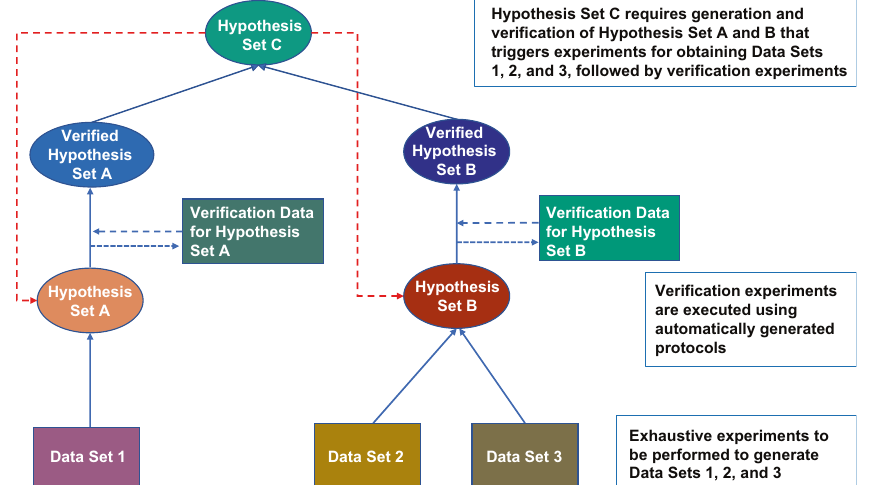
(cid:1) ; h 1 ; h 2 ; (cid:2)(cid:2)(cid:2) ; h n 1 1 1 1